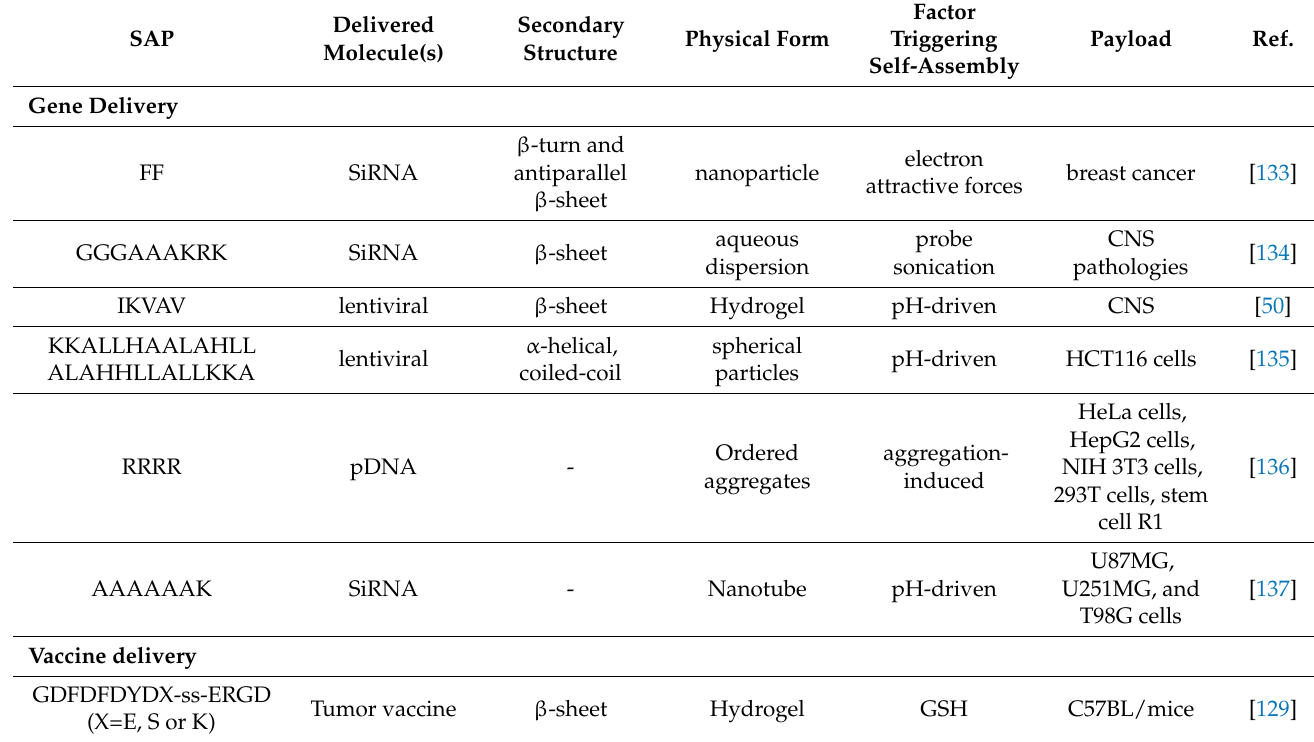
Table 2. Applications of genetic and immunomodulatory